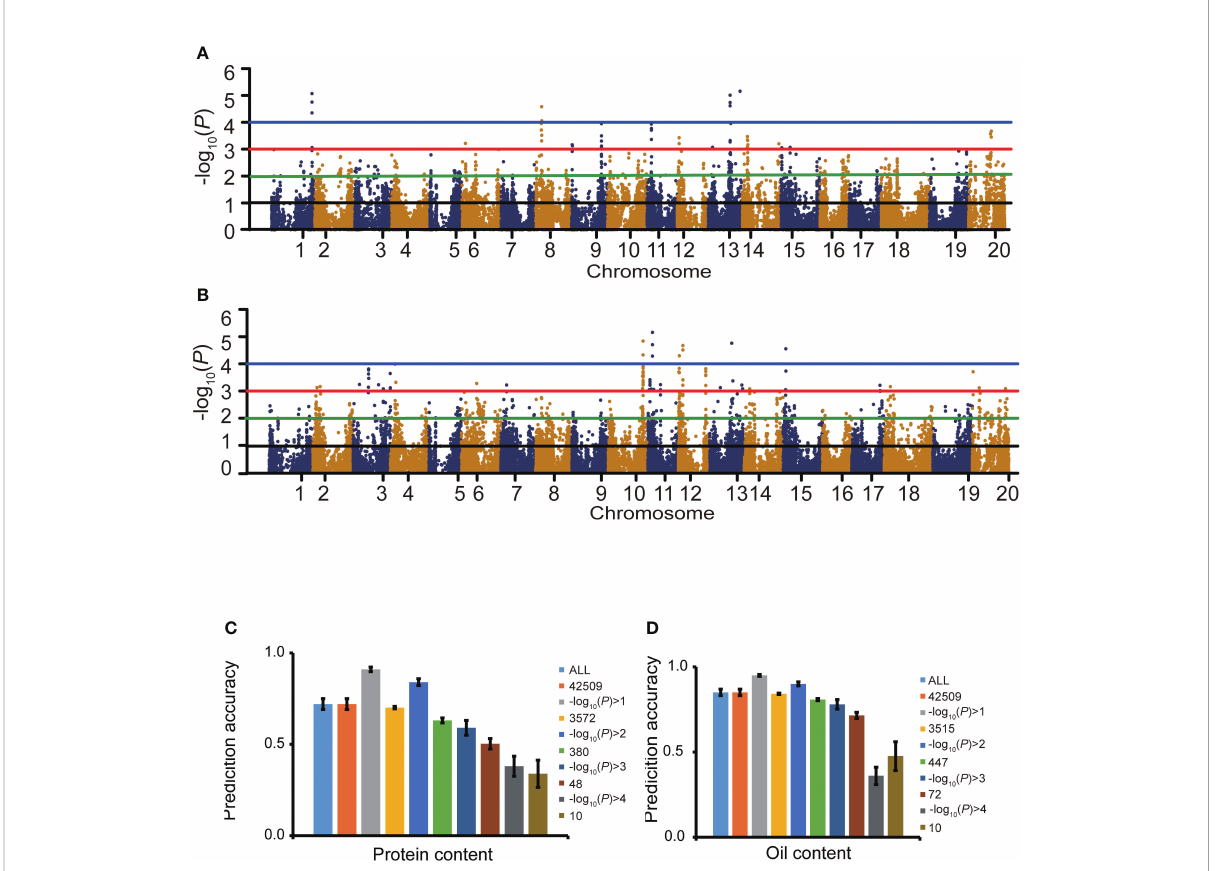
FIGURE 4 The effect of marker association with the trait on prediction accuracy. Manhattan plots for protein content (A) and oil content (B) . Effects of marker sampling strategies on cross-validated prediction accuracies of RRBLUP for protein content (C) and oil content (D) among 1,007 soybean germplasms grown at Urbana, IL in 2001 and 2002. Marker subsets were selected using random sampling (C, D) and an -log 10 ( P ) value- based sampling strategy (A, B) . The number of markers for random selection was the same as the number of markers selected based on the -log 10 ( P )